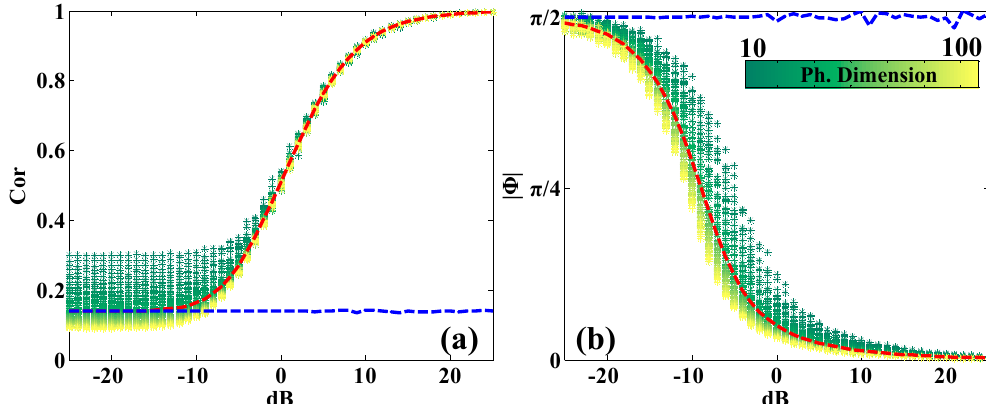
Figure 2. Monte Carlo simulation under di ff erent SNRs and phase dimensions for ( a ) correlation magnitude Cor and ( b ) rotation angle | Φ | . Dashed lines indicate mean value of all the di ff erent phase dimensions, red for the PCP pairs with the same true phase signal and blue for the non-PCP pairs with di ff erent phase signals. Color tone indicates di ff erent dimensions of